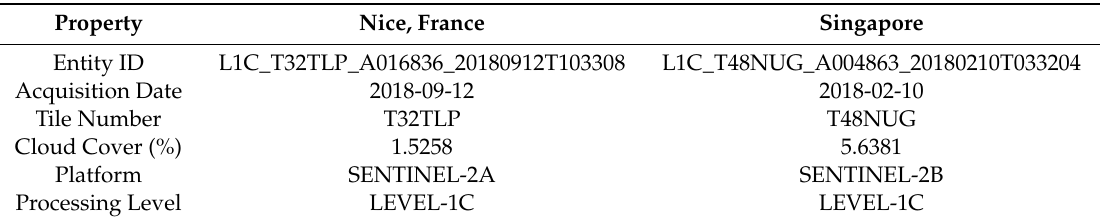
Table 1. Property of collected Sentinel 2 multispectral